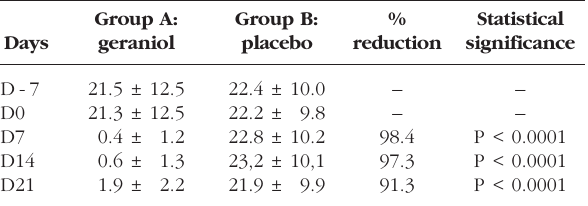
Table I. – Activity of 1 % geraniol in cattle, determined by the reduc- tion in average number of ticks (average number of ticks per ani- mal: n ± standard deviation).